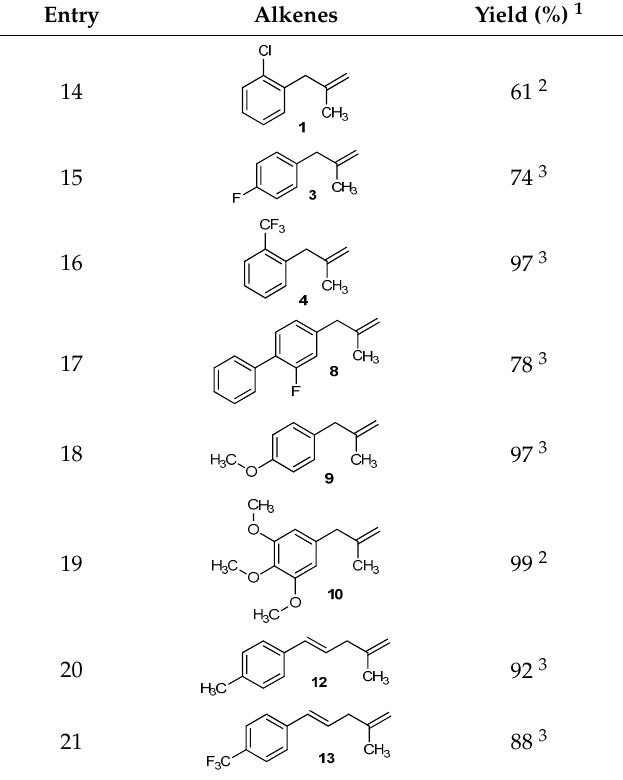
Table 2. Yield optimization for cross-coupled products.